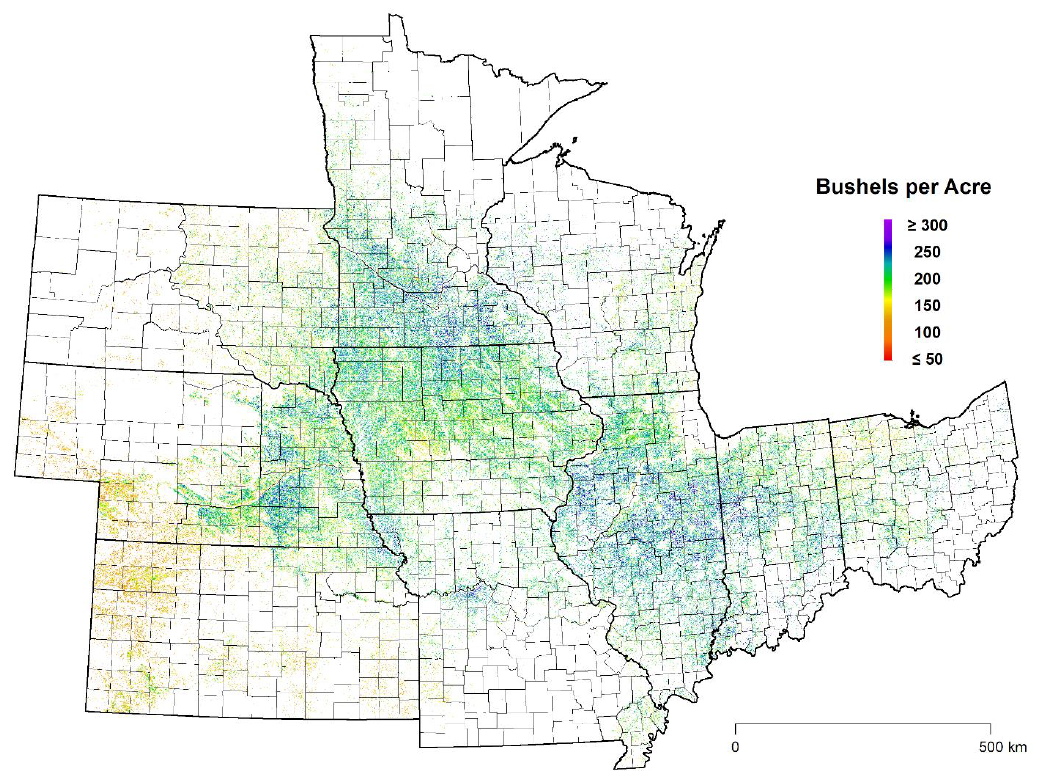
Figure 5. MODIS NDVI estimated 2020 corn yields over the Central USA Corn Belt based on accumulated over 0.58 NDVI methodology (1 corn bu/ac = 0.0628 mt/ha).